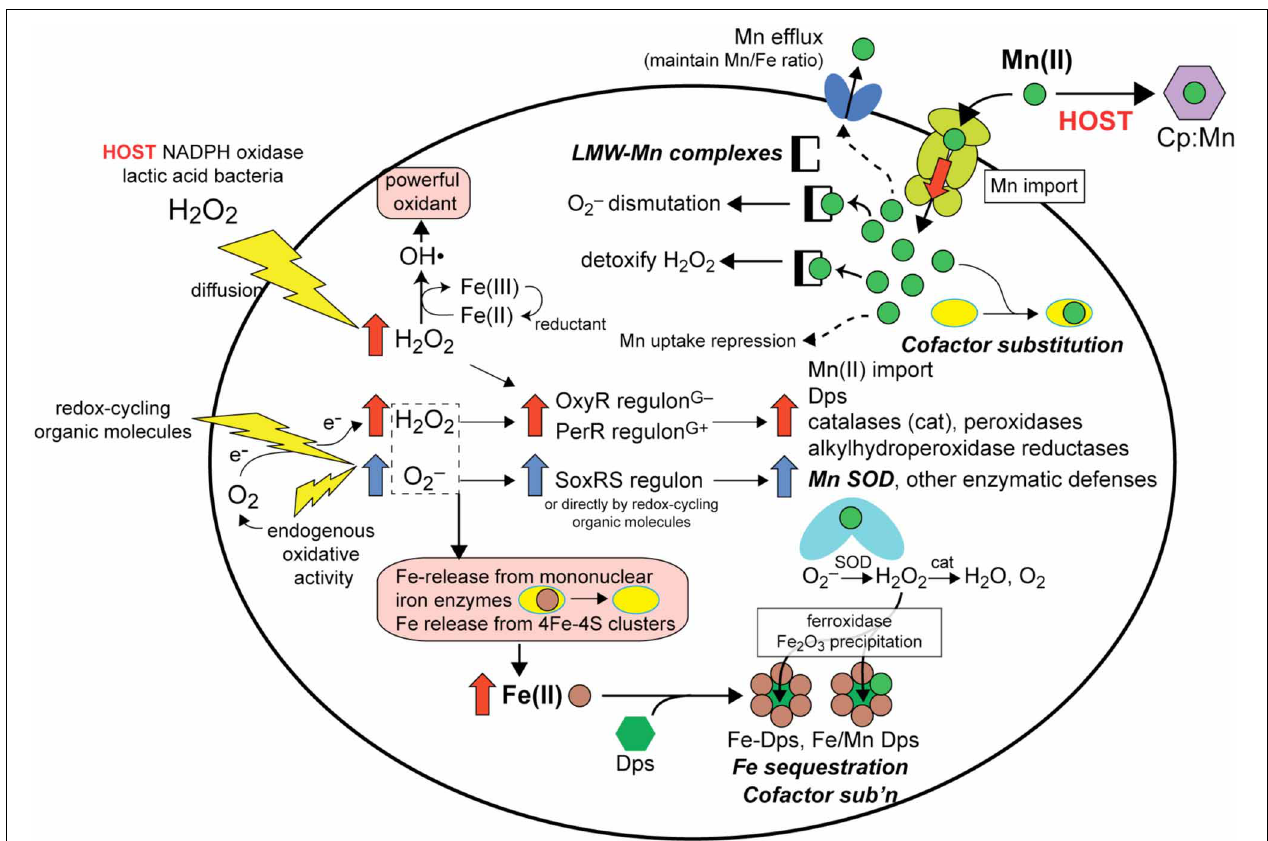
formation of OH • ( bottom, middle ). As a result of PerR/OxyR regulatory responses to ROS, increased expression of the Mn ( upper right ; ABC transporter schematic shown) importer lead to increased intracellular Mn(II) ( greencircles )that(2)increasestheconcentrationofLMW-Mncomplexesthat function to dismutate O 2 − and possible to detoxify H 2 O 2 ( upper middle ) (see Figure 4 ), (3) permits cofactor substitution of mononuclear Fe-containing enzymes ( yellow ellipses; right ) and perhaps of Dps ( lower right ) with Mn, and (4) enhances the metallation and increased activity of Mn SOD ( middle, right ). HostsattempttolimittheseresponsesthroughdirectcompetitionoftheMn(II) transporter with host-encoded calprotectin (CP; purple hexagon) for Mn ( upper right ) (see text for details). Increased intracellular Mn(II) will ultimately be sensed by the Mn-activated repressor (DtxR, PsaR, etc.) to repress uptake, while excess Mn(II) will be effluxed from the cell by a limited number of organisms (Rosch et al., 2009; Veyrier et al., 2011) in order to bring the Mn/Fe ratio back into balance (Veyrier et al.,